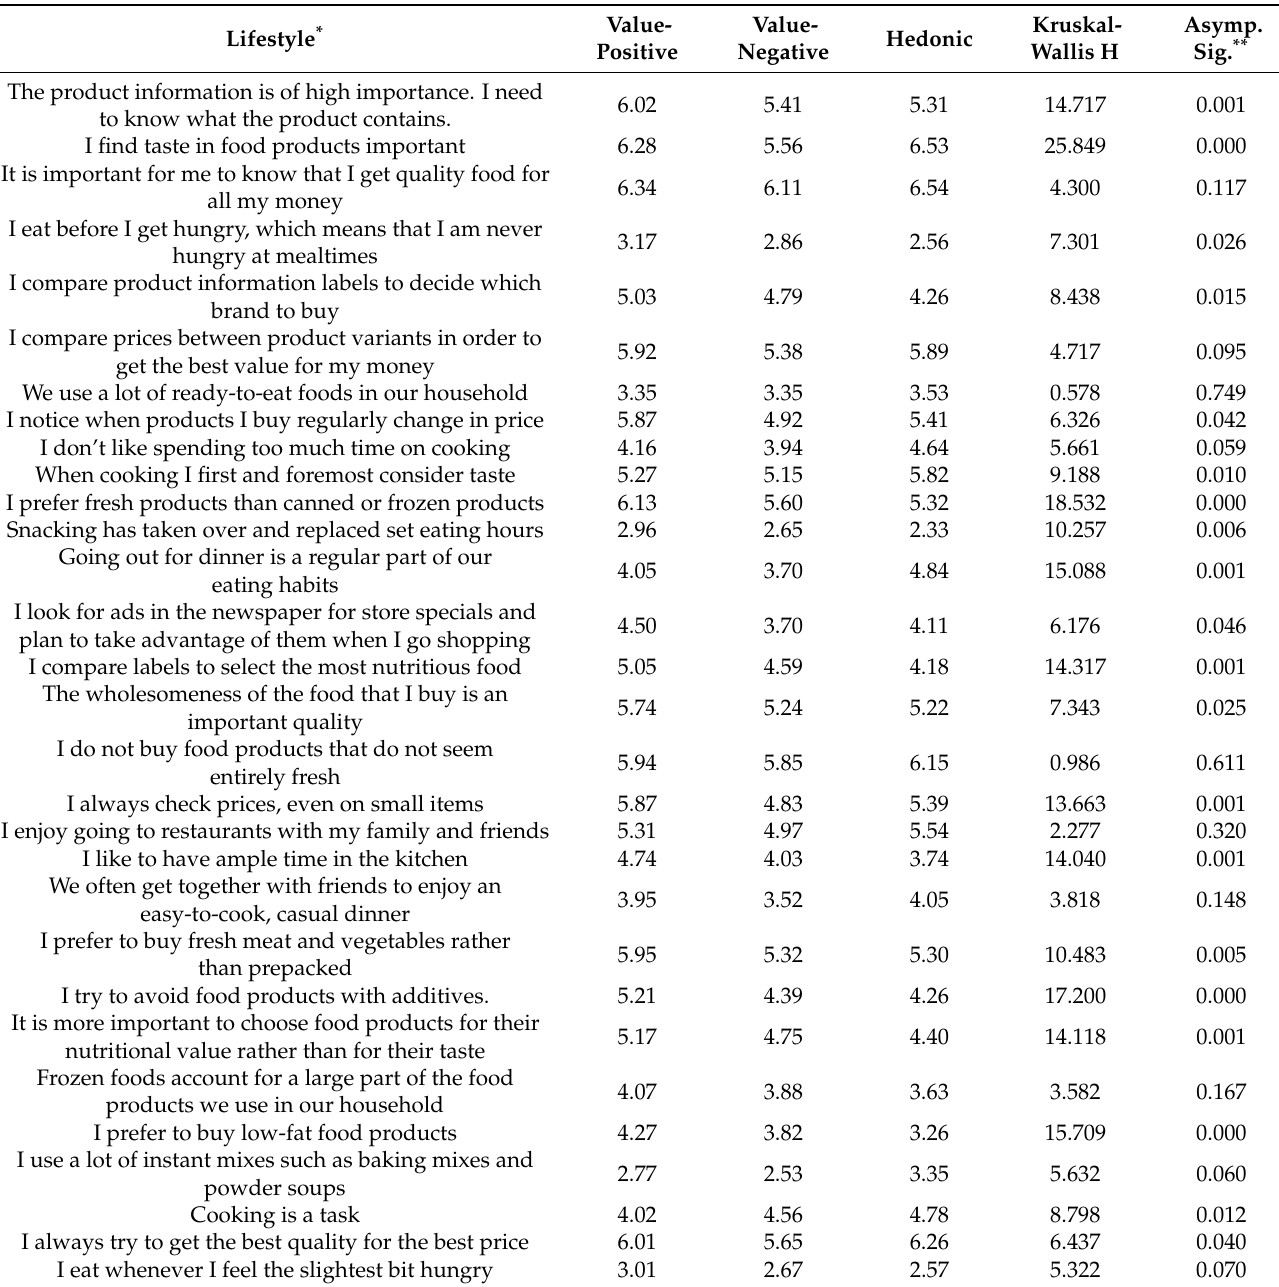
Table 11. Food-related lifestyle by consumer